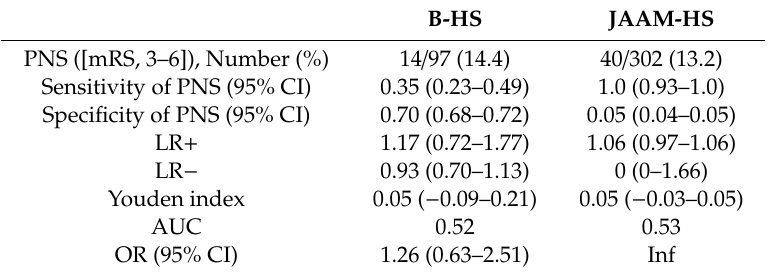
Table 5. Prediction of neurological outcomes between the B-HS and JAAM-HS patients.